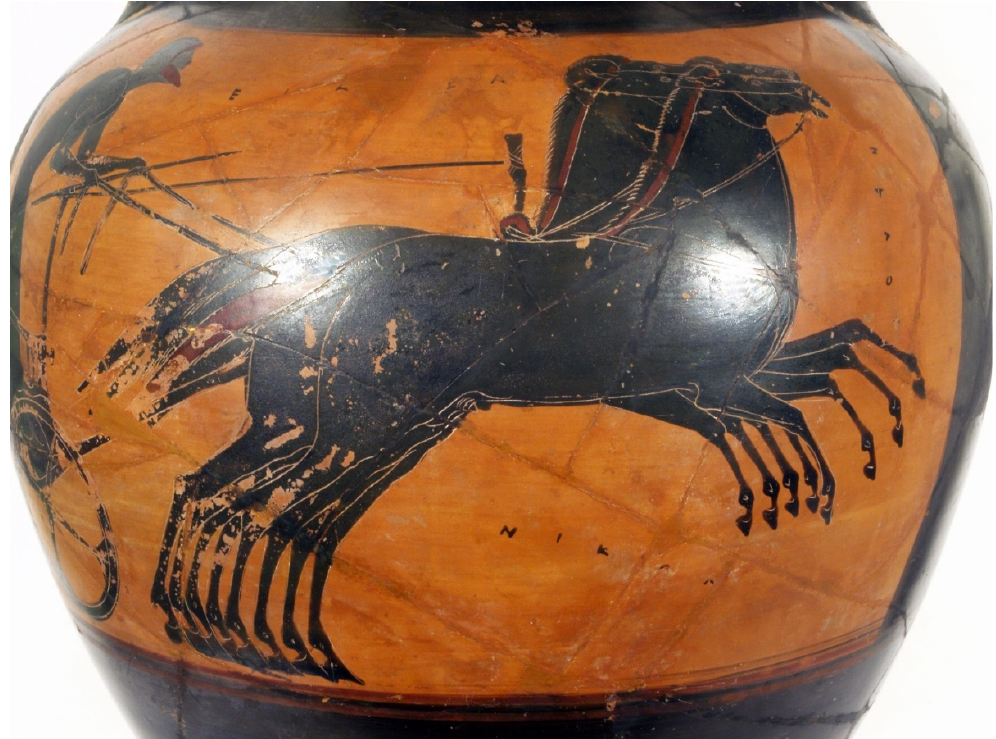
Figure 4. Inscriptions on the Pseudo ‐ Panathenaic Amphora, Mainz, Johannes Gutenberg Universität, 74.